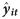
Posterior means of the fitted heroin-related incident counts (y^it) for a subset of the time periods.Geographic boundary files were downloaded from the US Census, TIGER, Geodatabase [41].